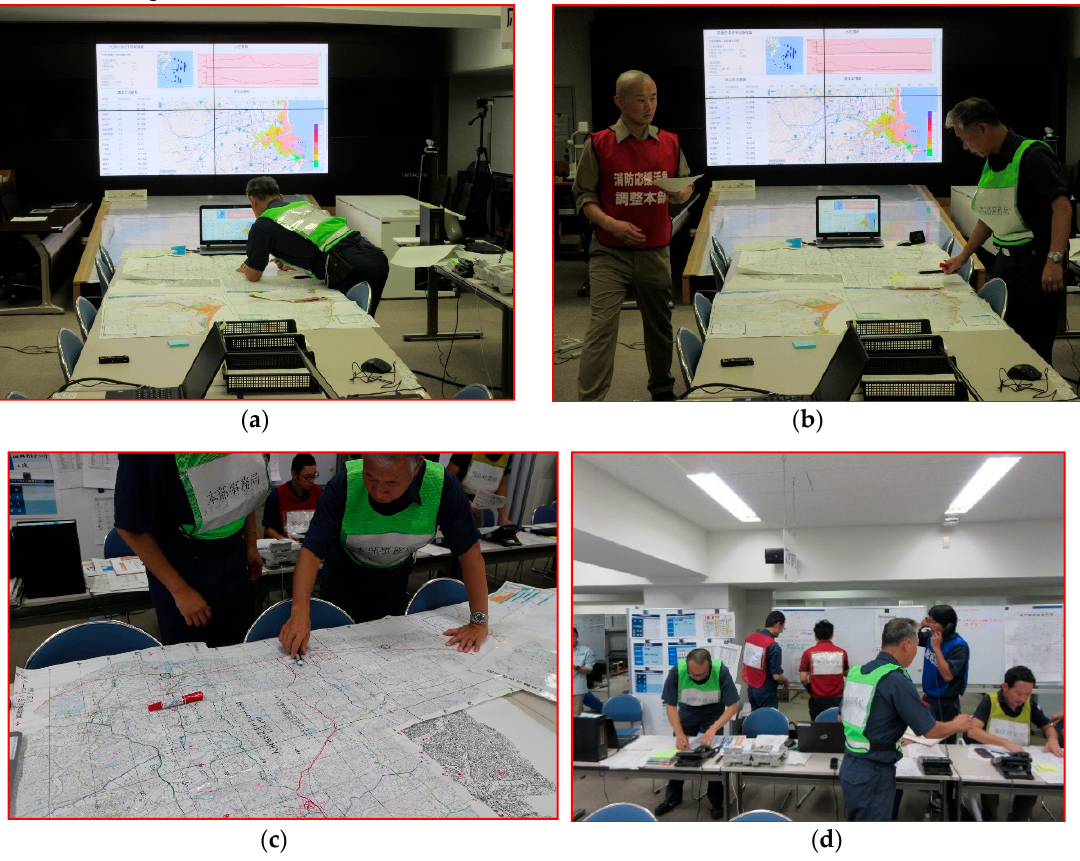
Figure 12. Photographs of the second TTX: ( a ) shows staff using the Real-Time Tsunami Prediction system and drawing the tsunami inundation area on the map; ( b ) shows staff confirming the hazard map area by comparing it with the tsunami inundation area provided by the Real-Time Tsunami Prediction system; ( c ) shows staff gathering the information on the map; ( d ) shows staff requesting a disaster response from the participants.